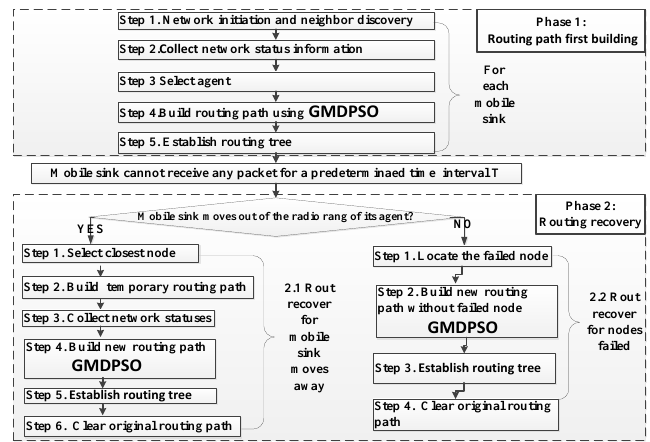
Figure 3. Flowchart of new routing protocol.